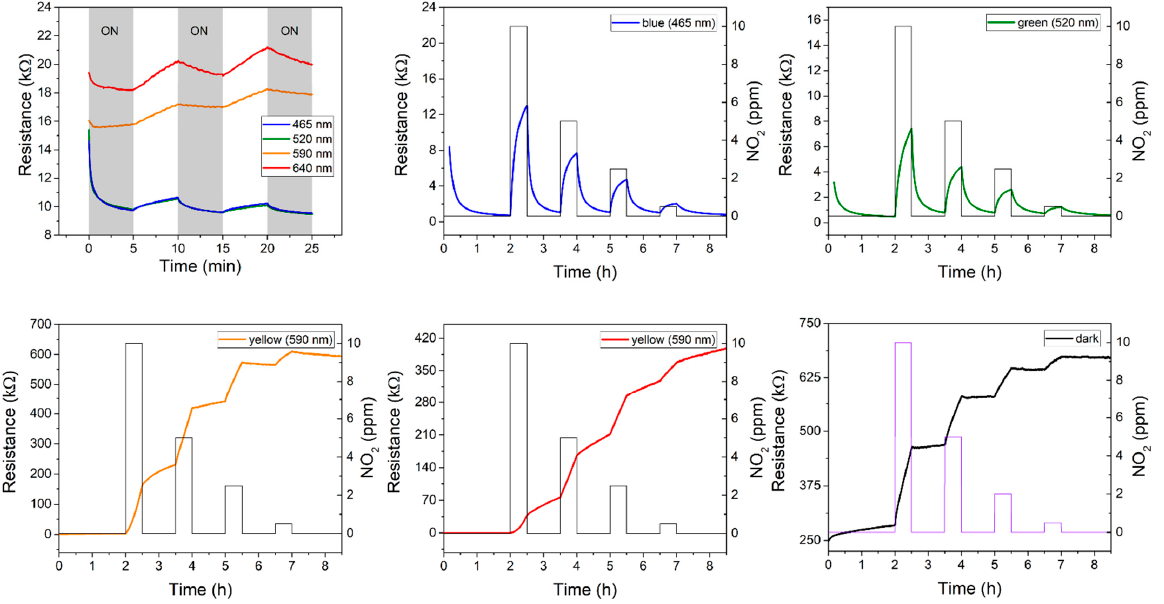
Figure 7. The dynamic sensing responses of ZnO NRs/Au NPs. The adsorption/desorption process emerged on blue and green LED due to their energy. Meanwhile, for the yellow, red LED, and dark conditions, the energy is not sufficient to release the adsorbed NO 2 onto the surface of ZnO NRs at room temperature.